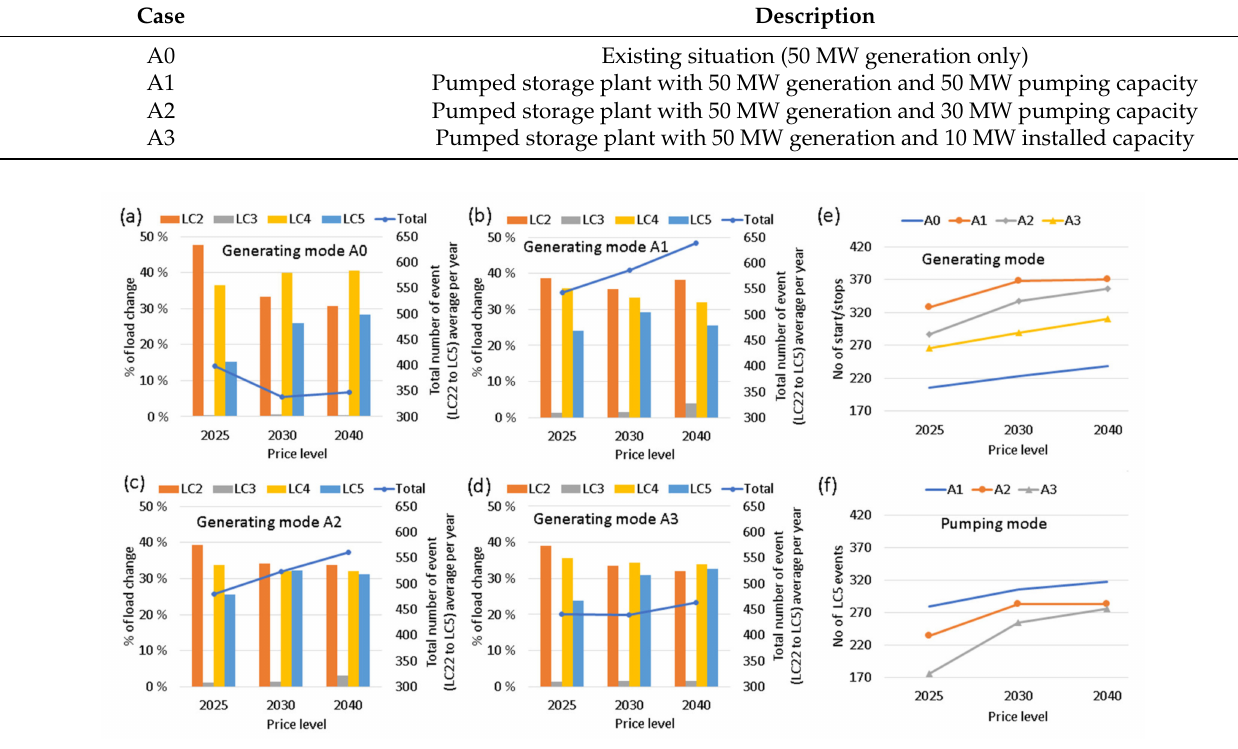
Figure 6. Trend of load changes of different magnitudes with future price